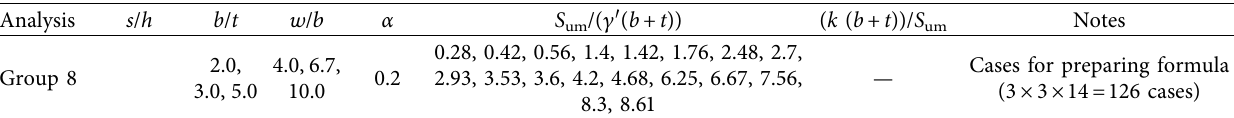
trifuge tests were in good agreement in terms of failure mechanism, soil heave, and cavities’ locations and shapes. It can be found that gaps exist between